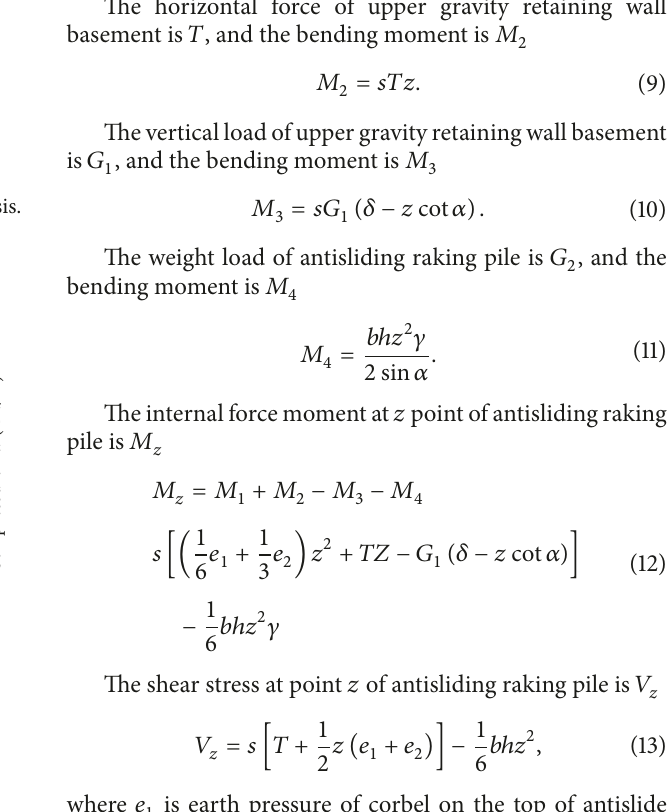
dip angles of retaining wall 𝛼 = 90 ∘ , 𝛼 = 100 ∘ , 𝛼 = 110 ∘ , 𝛼 = 120 ∘ , 𝛼 = 130 ∘ , and 𝛼 = 140 ∘ as shown in Figure